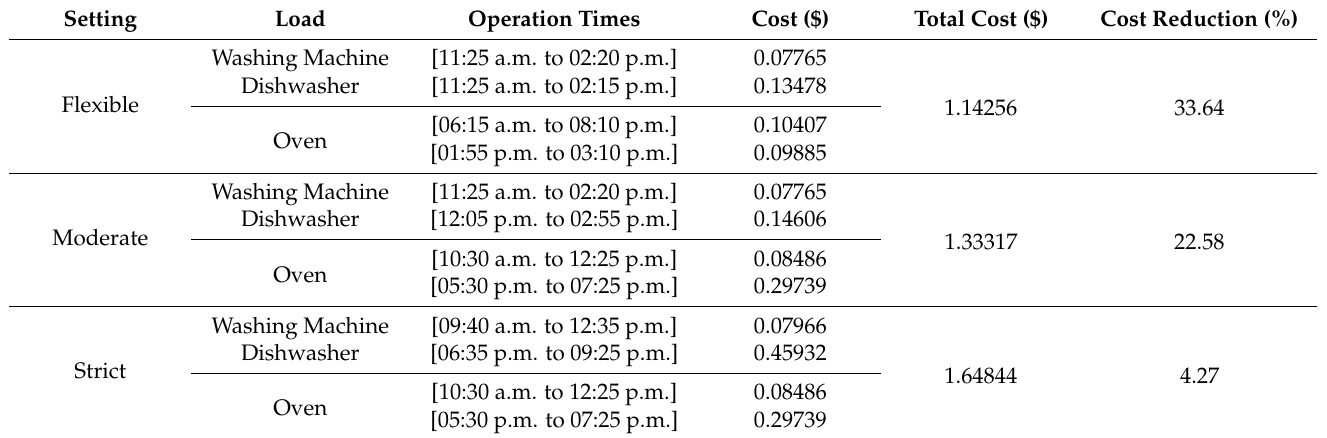
Table 4. Result Summary for Scenario